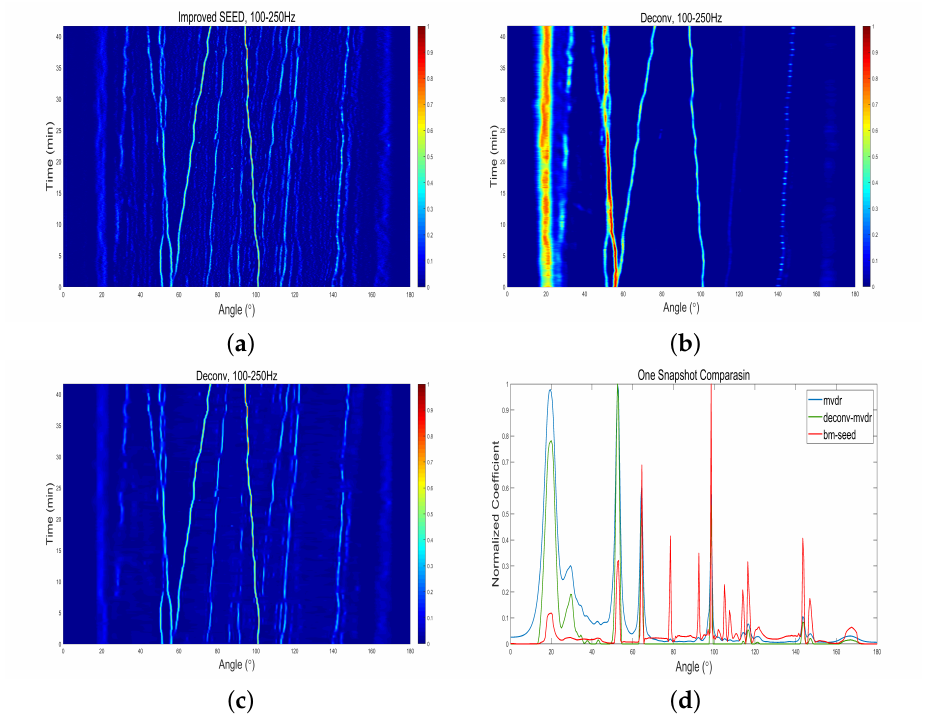
Figure 11. Sea-trial experiments 2. ( a ) improved SEED; ( b ) Deconv MVDR1; ( c ) BM-SEED MVDR1; ( d ) Snapshot